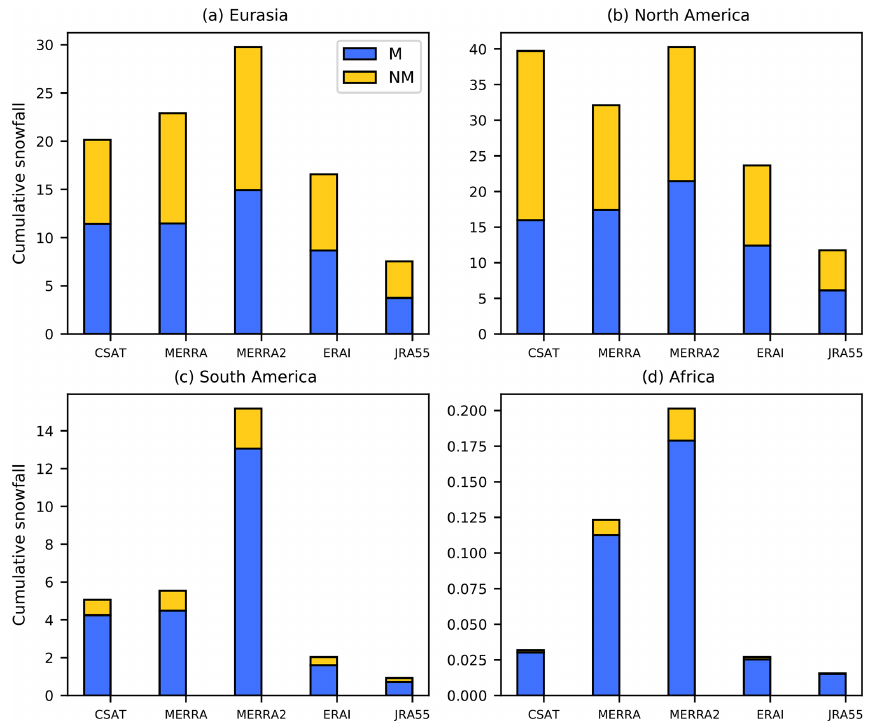
Figure 4. Snowfall estimates (millimeters per month per grid box) over (a) Eurasia, (b) North America, (c) South America and (d) Africa for CloudSat, MERRA, MERRA-2, ERA-Interim and JRA-55 over the time period 2007–2016. Mountain snow is in blue, and non-mountain snow is in